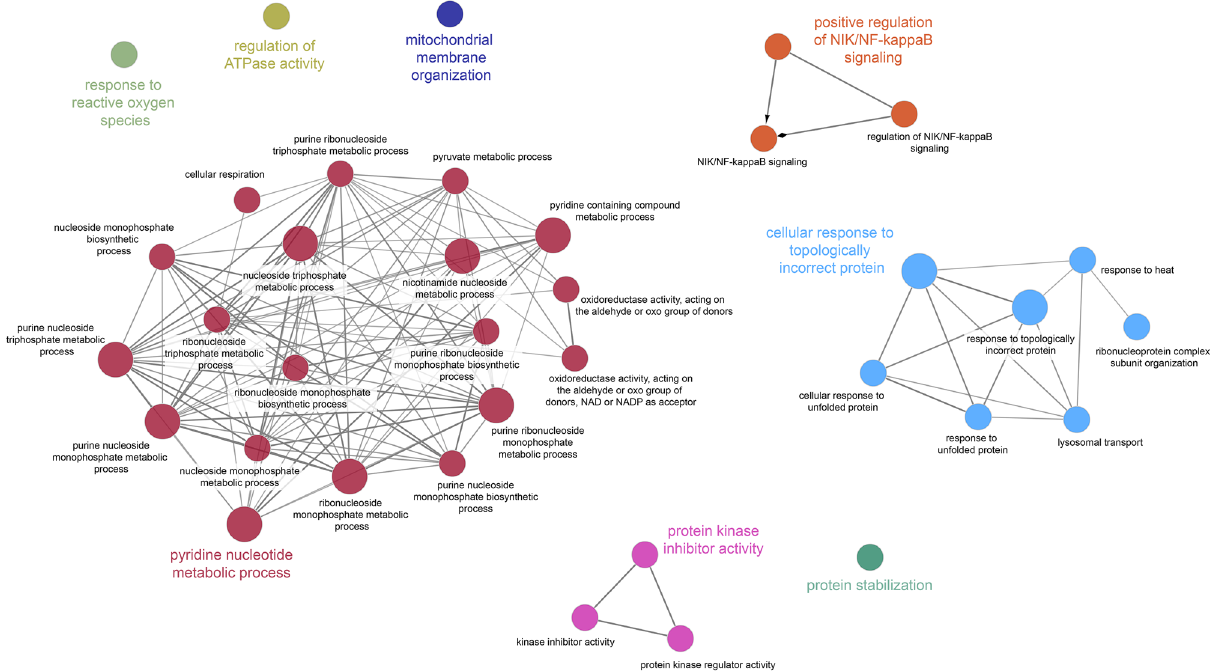
Figure 3. Functional classification of differentially ( P < 0.05) expressed proteins in jejunal mucosa of dairy cows after 4 days of heat stress based on Gene ontology biological processes using ClueGO software 61 (version 3.8.0; Cytoscape Software; https:// cytos cape.